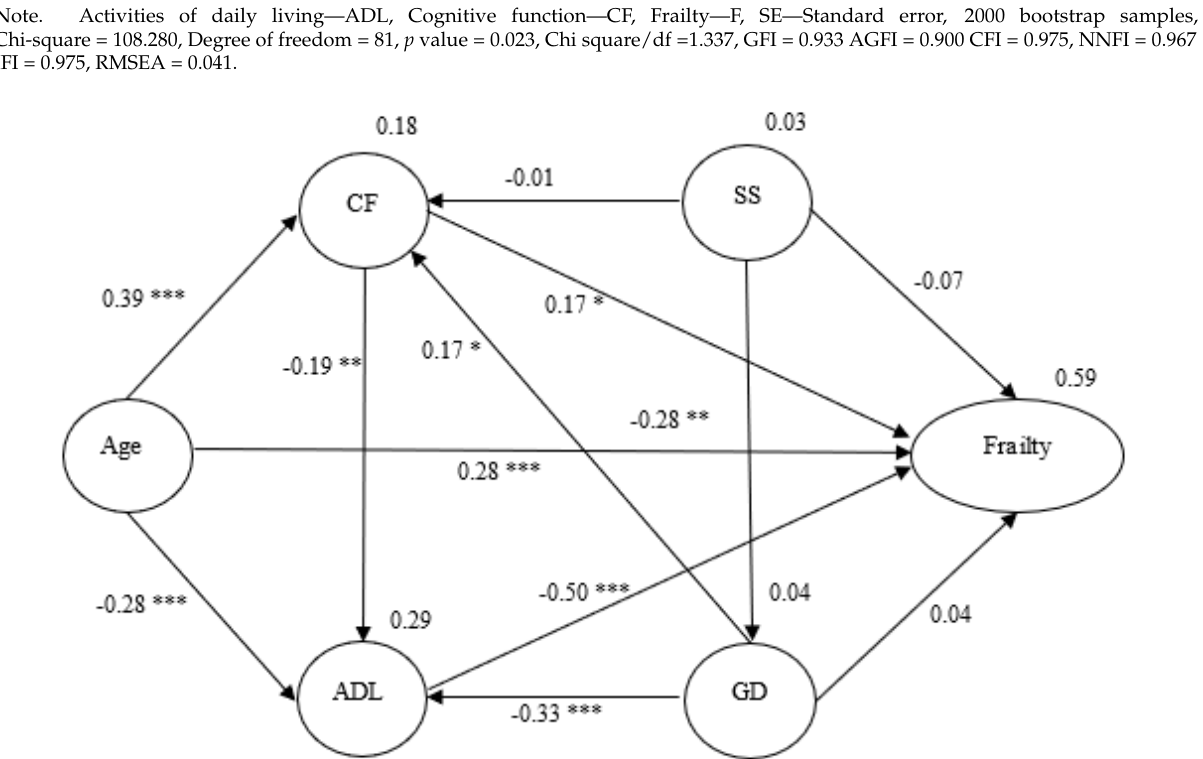
Table 3. Parallel multiple mediator model for effect of age on frailty.